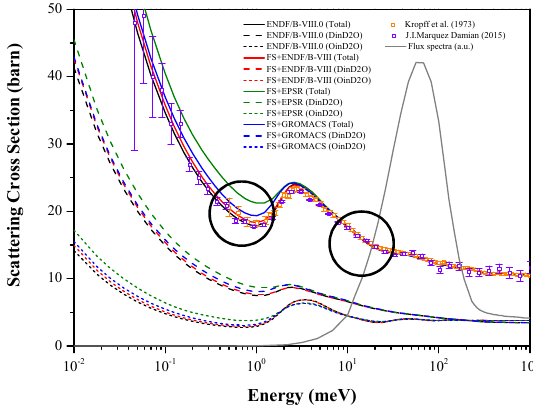
Fig. 3. Scattering cross sections for heavy water and the flux spectrum in the thermal system